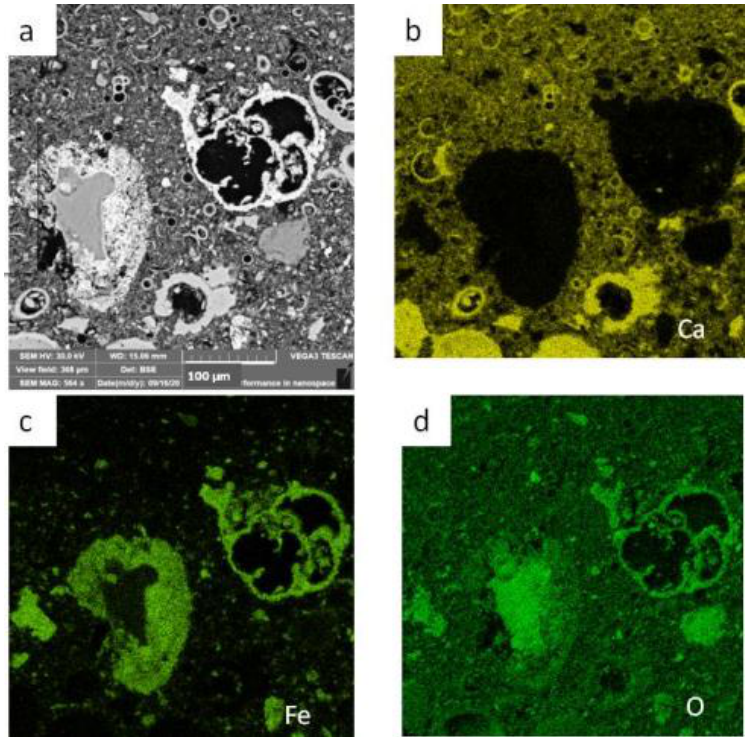
Figure 7. The SEM images of core 184k, the sediment layer of 38–42 cm; ( a ) back scattered electrons’ image; b–d, maps of the element distribution: ( b ) Са; ( c ) Fe; ( d ) O.